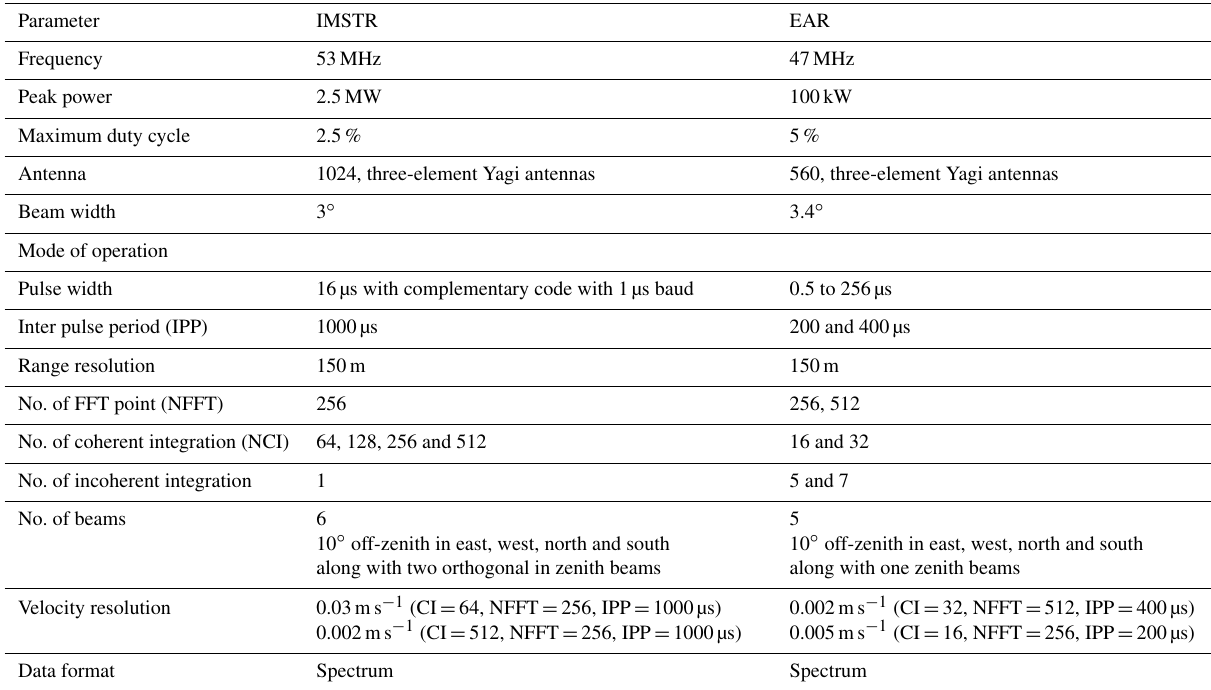
Table 1. The radar specifications and parameters used for the present